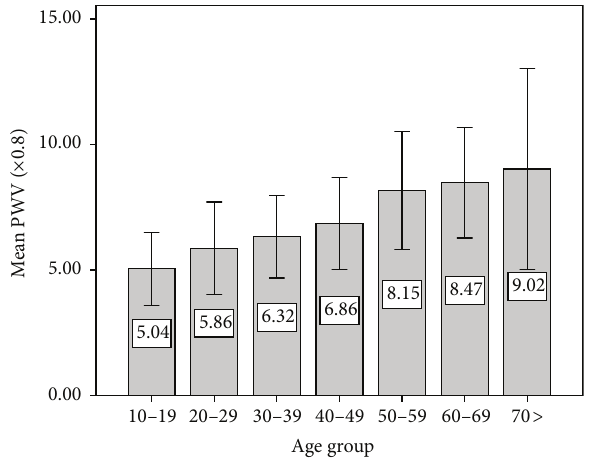
Figure 2: Evolution of the mean values of the pulse wave velocity (mean ± SD) according to age